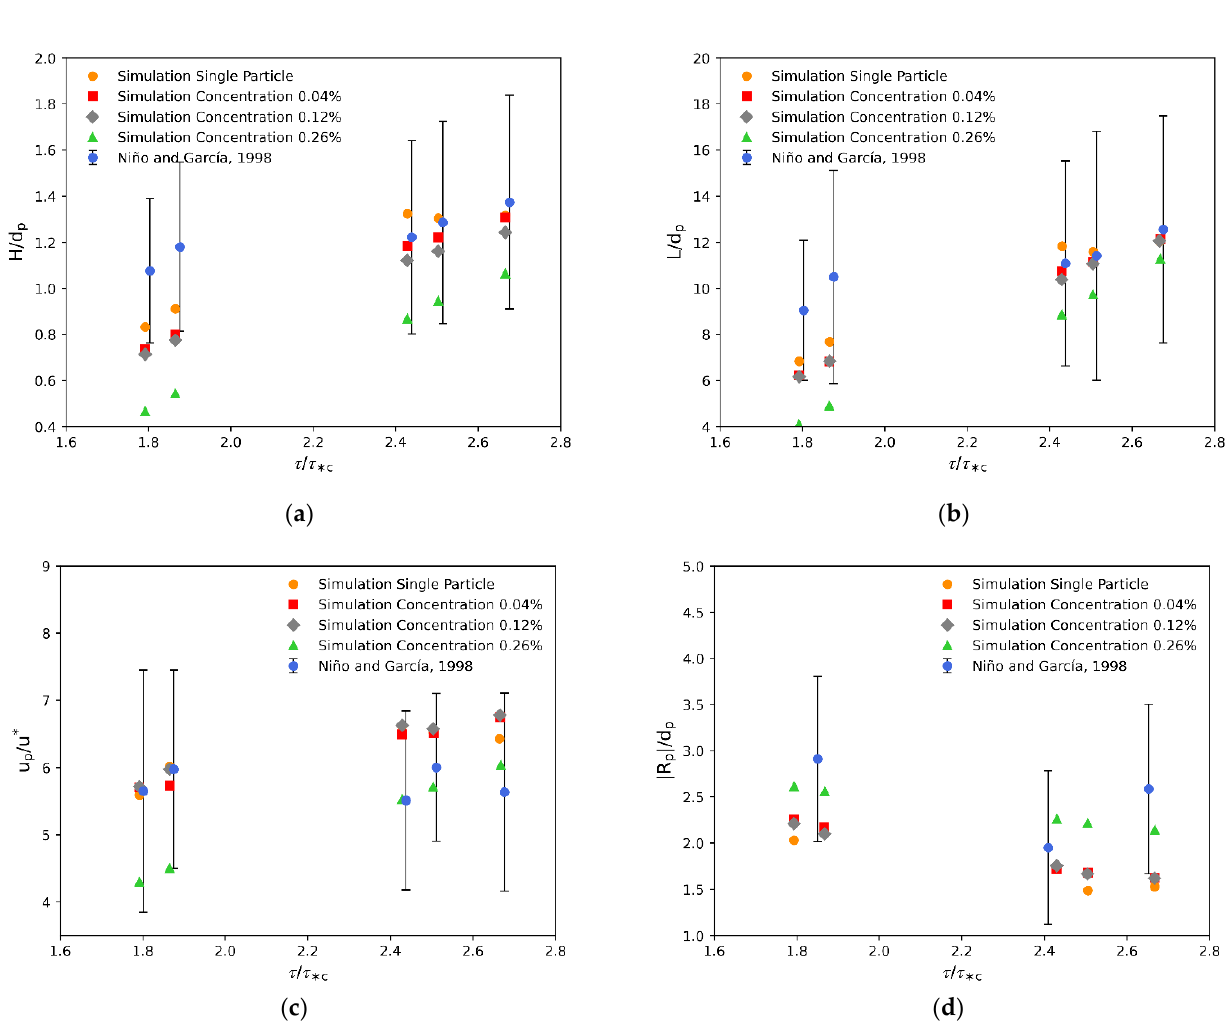
Figure 5. Sample of multiparticle simulation results for concentrations of 0.04, 0.12, and 0.26% by volume, compared against experimental results from Niño and García (1998) [42] and simulation from a single particle. ( a ) Dimensionless average jump height, ( b ) dimensionless average jump length, ( c ) dimensionless particle streamwise velocity, and ( d ) dimensionless particle rotation in the spanwise direction. Only standard deviations from Niño and García are shown for the sake of clarity.